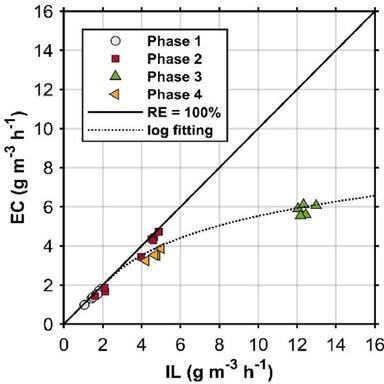
IL vs EC for stable state conditions. A logarithmic regression was fit on the data (EC ¼ 2.19 ln(IL) þ 0.48). Details about phase 1 to 4 can be found in Appendix C.